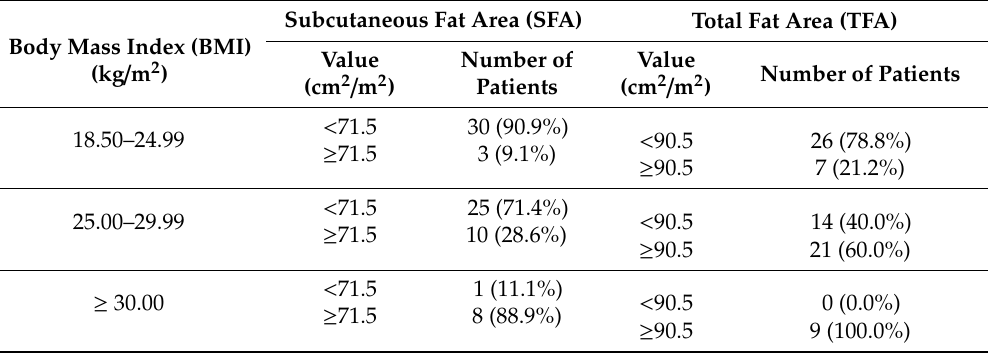
Table 4. Distribution of HCC patients undergoing liver transplantation with SFA and TFA under and above established thresholds according to BMI